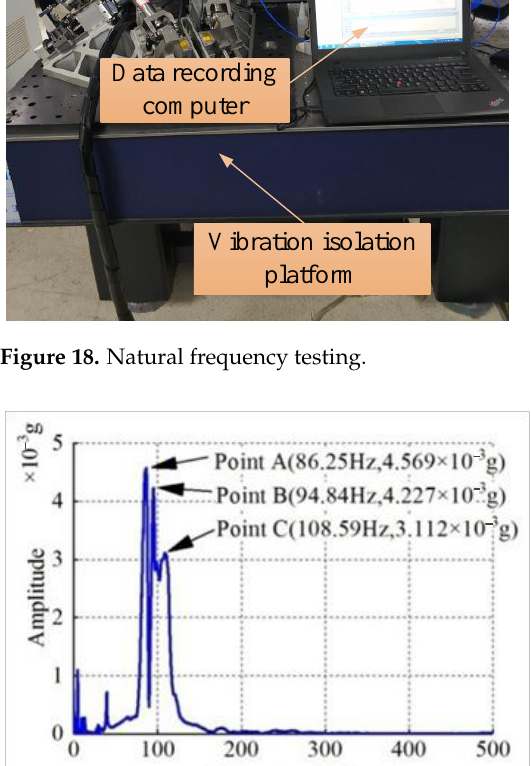
Figure 19. Vibration response curve.